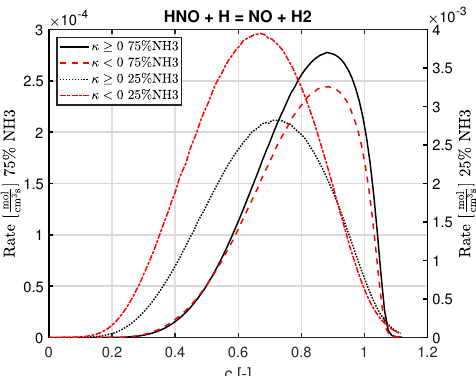
Figure 10. Reaction rates of NO-producing reaction for a constant equivalence ratio of 0.8 for 75% and 25% NH 3 . The rates for the 25% NH 3 case have been plotted on the right y-axis. This can also be explained similarly as for the trend observed for the source term of NH 3 , where the H radical, although it is supposed to enhance reactions for negative curvatures, does not for the highest amount of ammonia due to a possible competition between the reaction and diffusion timescales of the species. Additionally, the